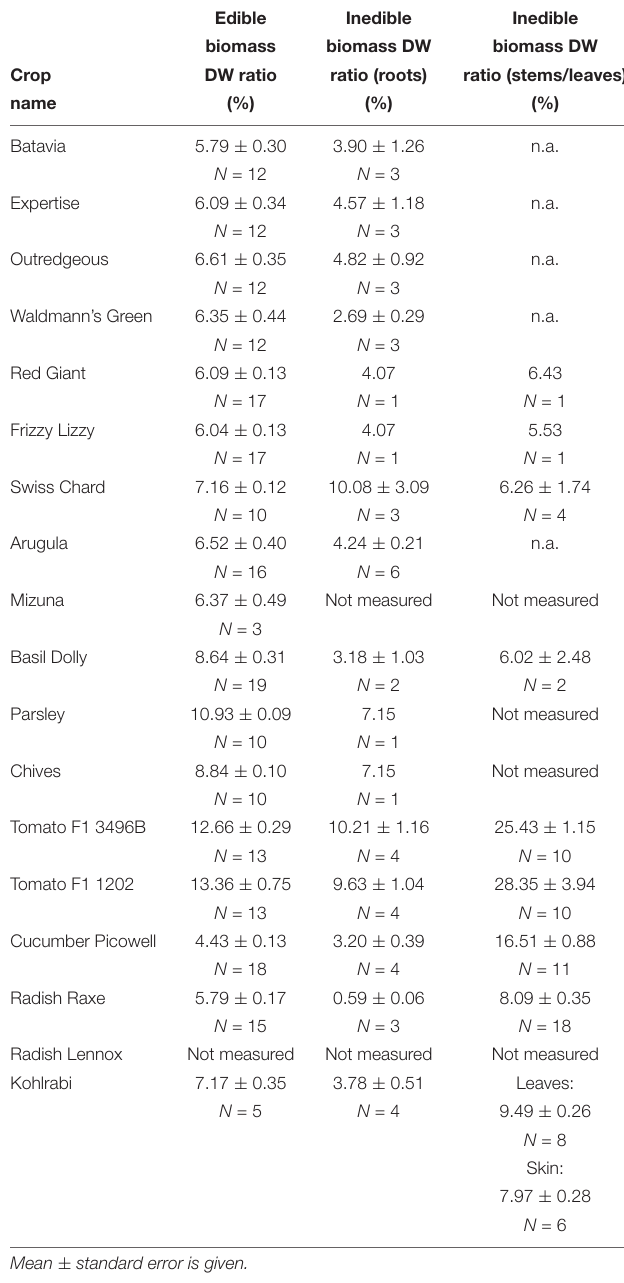
TABLE 5 | Inedible biomass production overview. Crop